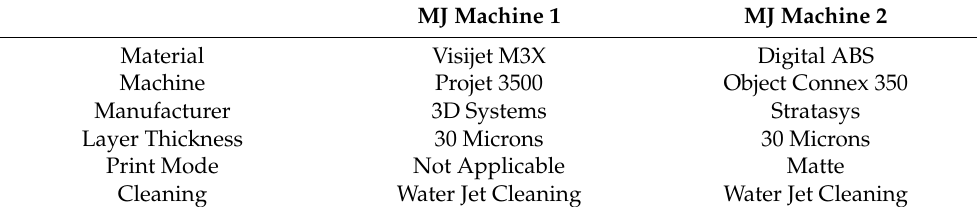
Table 2. Machine and material specification used for printing 3DIM inserts.